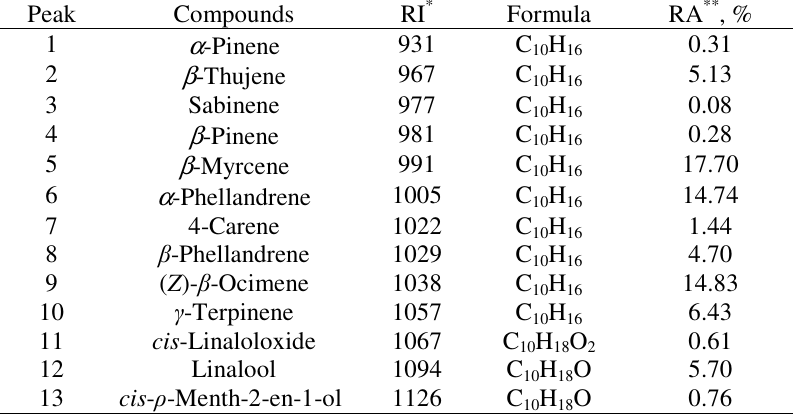
Table 1. Chemical constituents of essential oil from Ligusticum chuanxiong